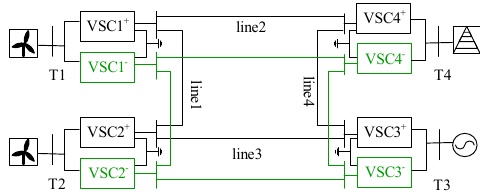
Figure 7. Topology diagram of 4-terminal VSC-MTDC.